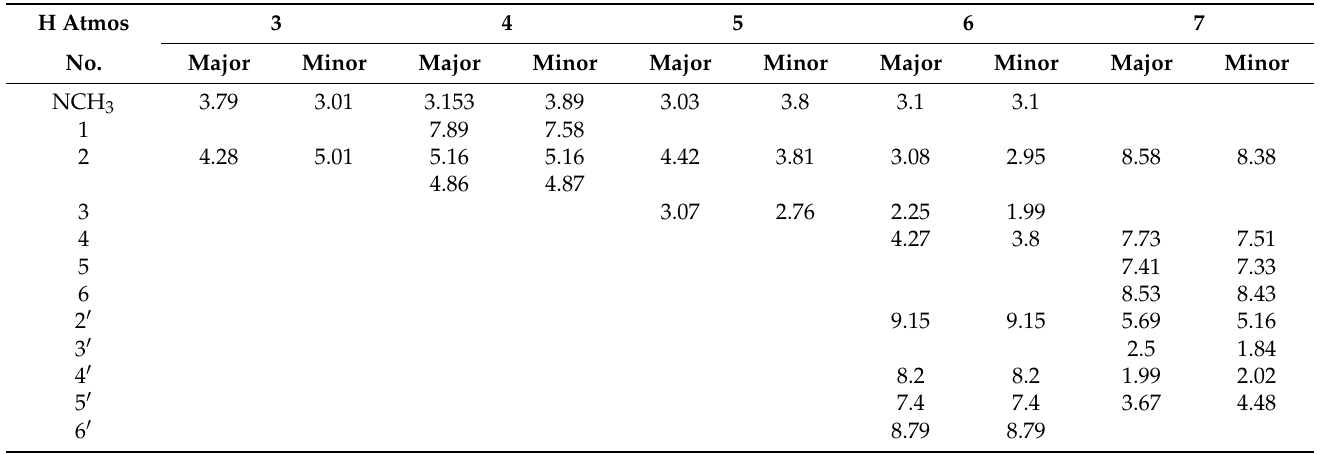
Table 1. 1 H-NMR chemical shifts of asymmetrical N-nitrososarcosines 3 – 7 .